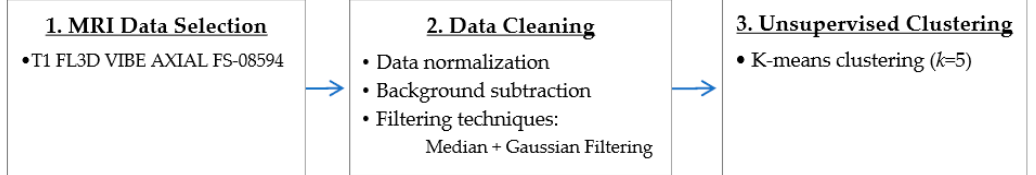
Figure 1. Schematics of the methodology pipeline followed to obtain the matrices required for the initialization of the 3D anthropomorphic phantom generator.